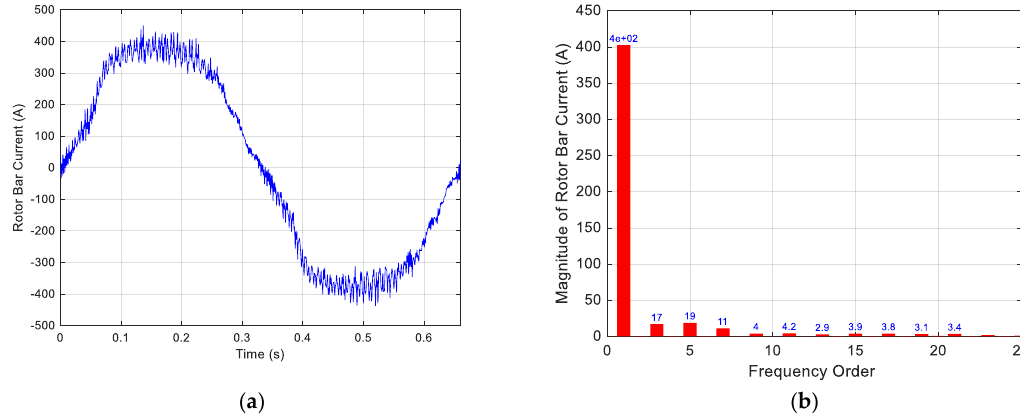
Figure 7. ( a ) Time dependency of bar current ( left ) and ( b ) its harmonic spectrum ( right ).